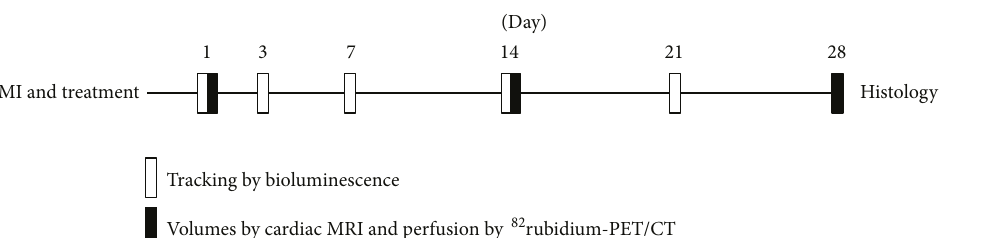
Figure 1: Experimental setup. Myocardial infarction was induced and rats were treated with either saline, ASCs in saline, or ASCs in alginate hydrogel on day 0. The ASCs were tracked at days 1, 3, 7, 14, and 21 after administration, with a subgroup being tracked 6 hours after injection. Functional measurements were obtained using cardiac magnetic resonance imaging (cardiac MRI) and rubidium-82 positron emission tomography/computer tomography ( 82 Rb-PET/CT) at days 1, 14, and 28